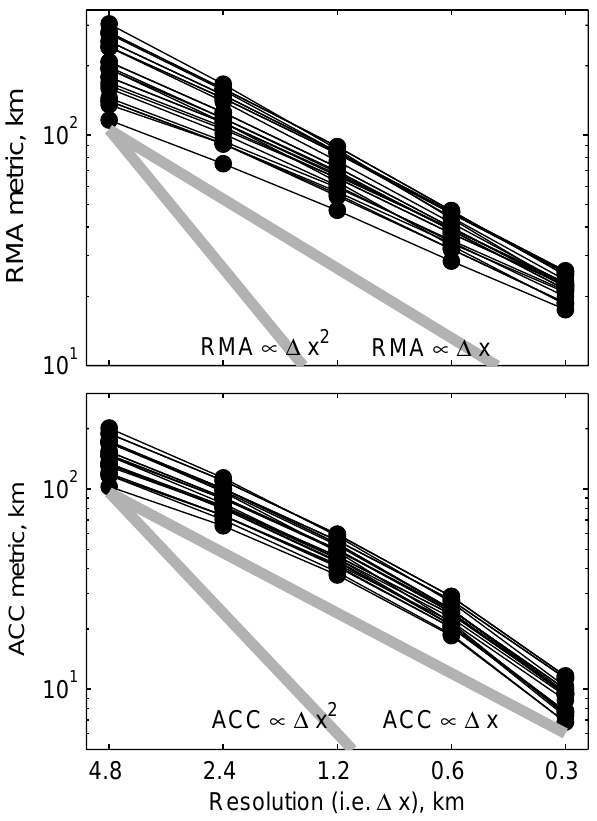
Fig. 7. Error metrics ACC and RMA (Sect. 4.1) against resolution. Results are shown for all GLPs (see Table 1). Example first order and second order convergence (grey bars) are shown for comparison (note that the starting point of the grey bars is arbitrary, it is the gradient that defines the order of